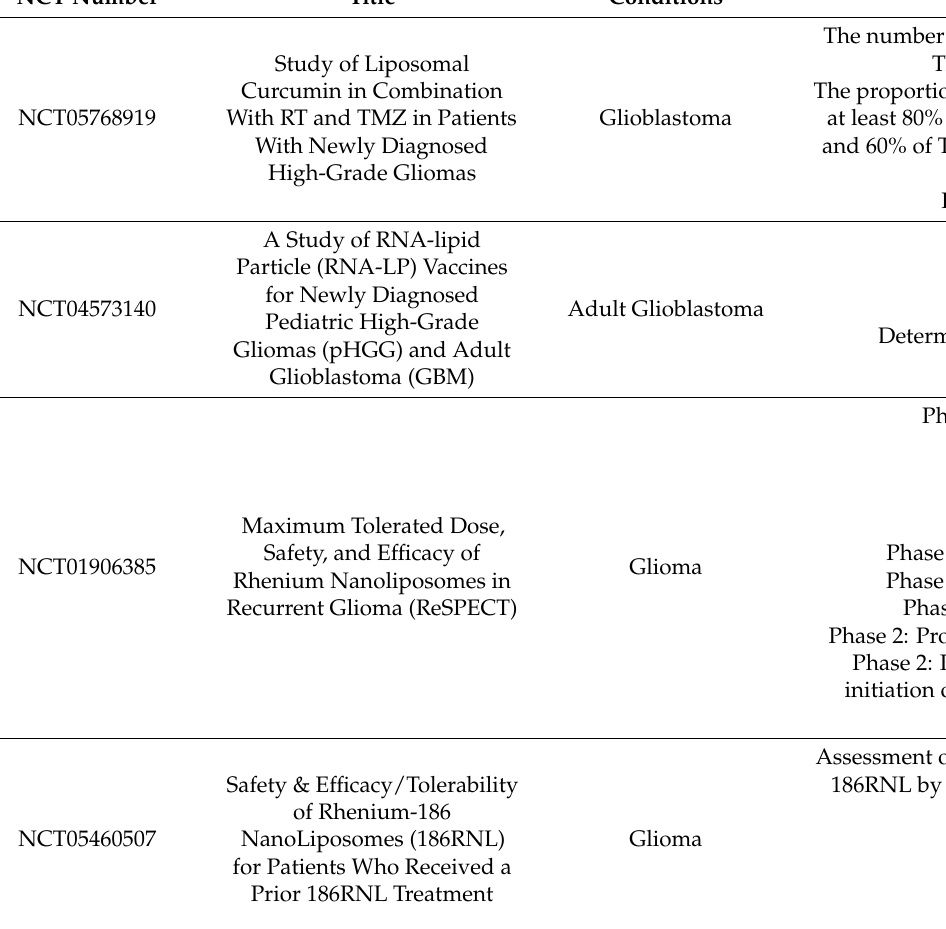
The number of observed Dose Limiting Toxicity (DLTs) The incidence of Adverse Events The proportion of patients at each dose level who receive at least 80% of the planned infusions of LC, 80% of RT, and 60% of TMZ during the first 10 weeks of